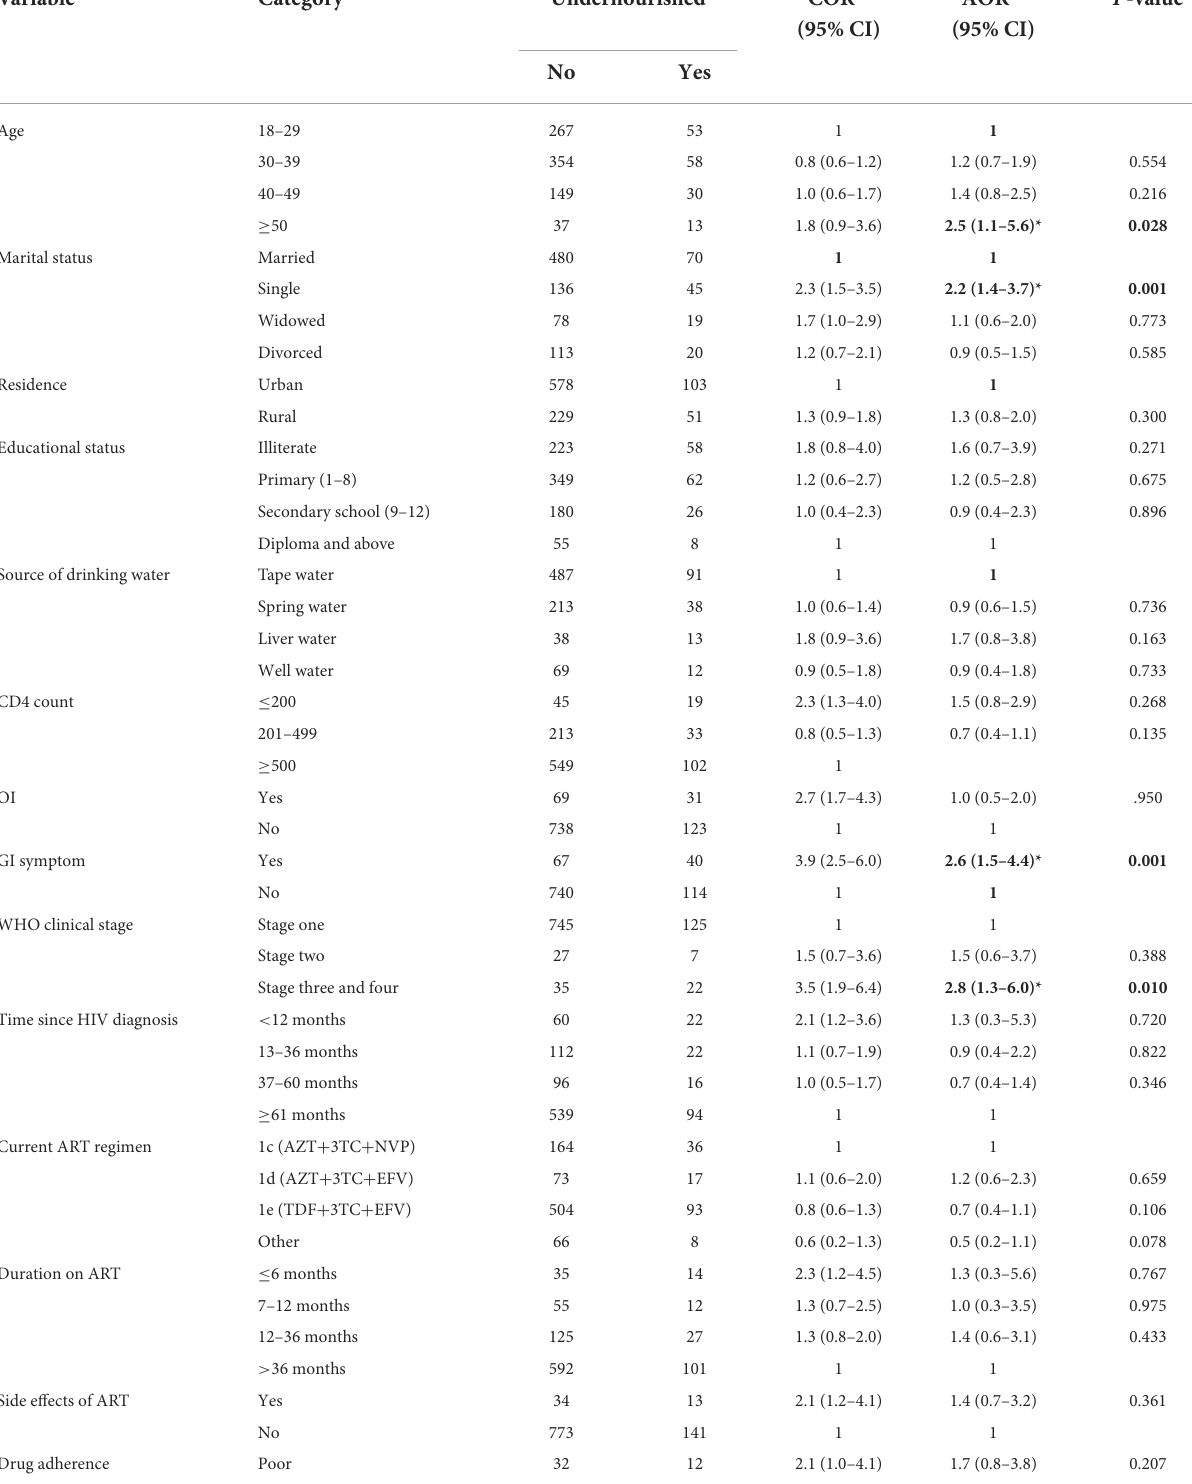
TABLE 5 Multivariable logistic regression analysis of undernutrition and its associated factors among people on HAART in health facilities in the Bench Maji Zone, Ethiopia, 2018. Variable Category